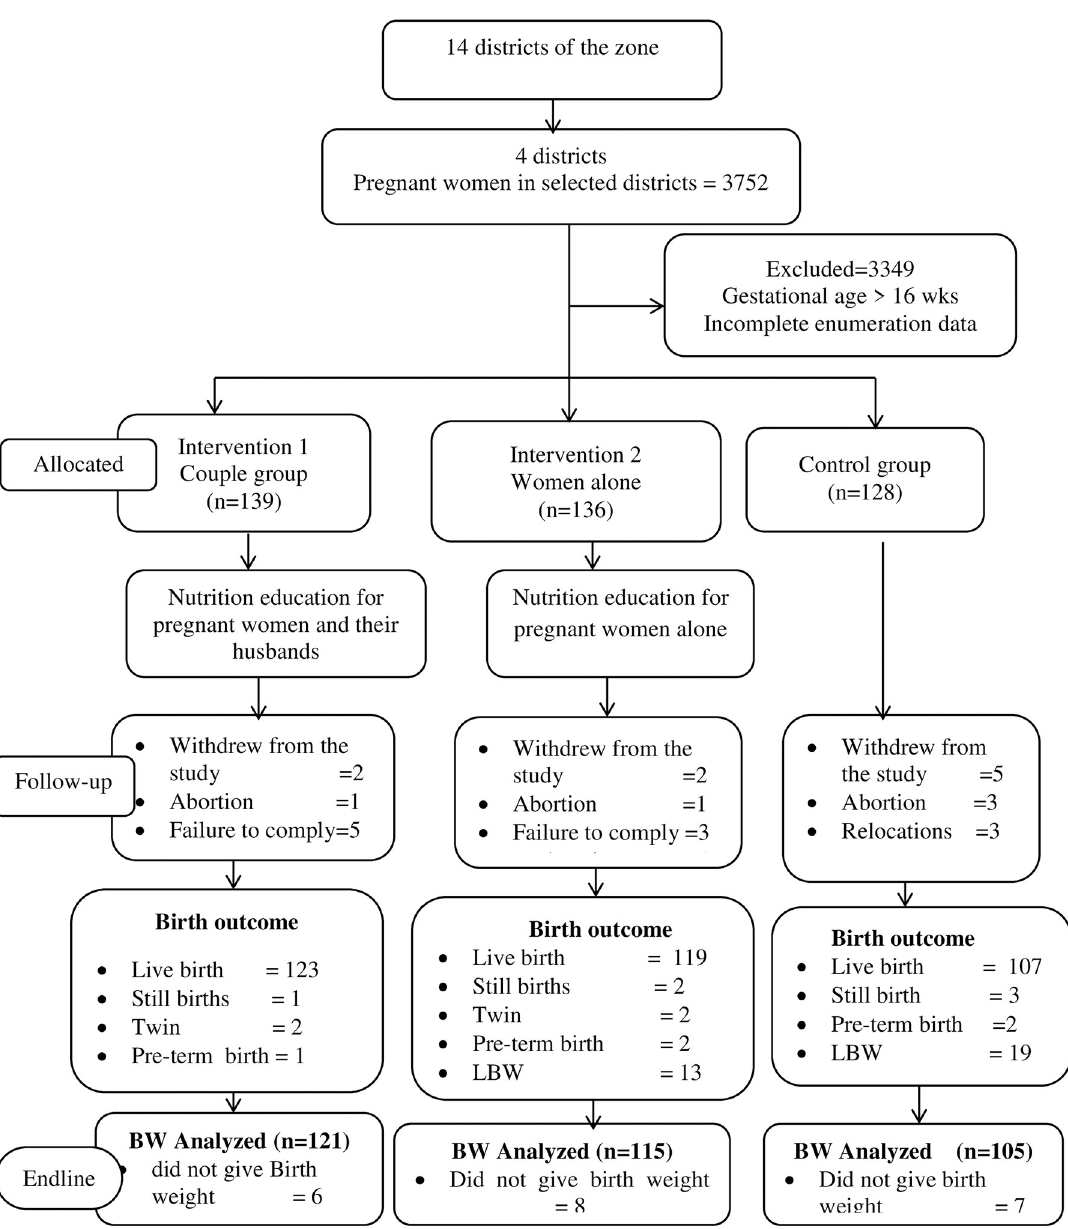
Fig 2. Trial flow diagram of the progress of study participants through the phases of the intervention. Note: live birth includes the twins and preterm births BW–birth